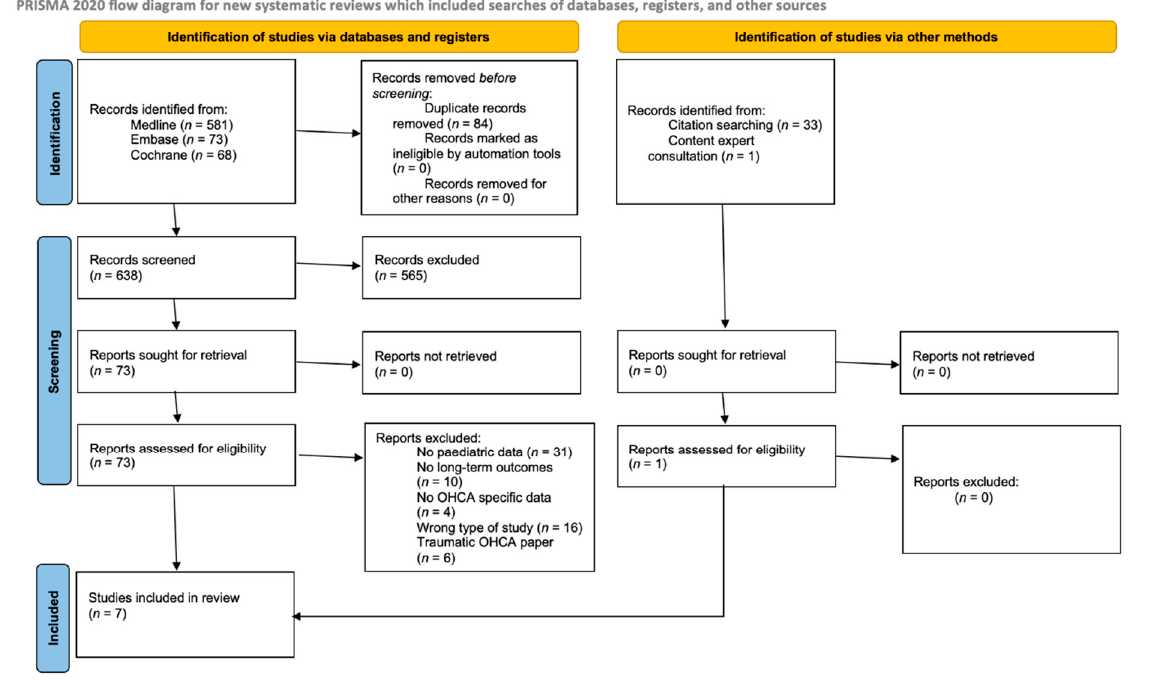
Figure 1. PRISMA-P 2020 flow diagram.